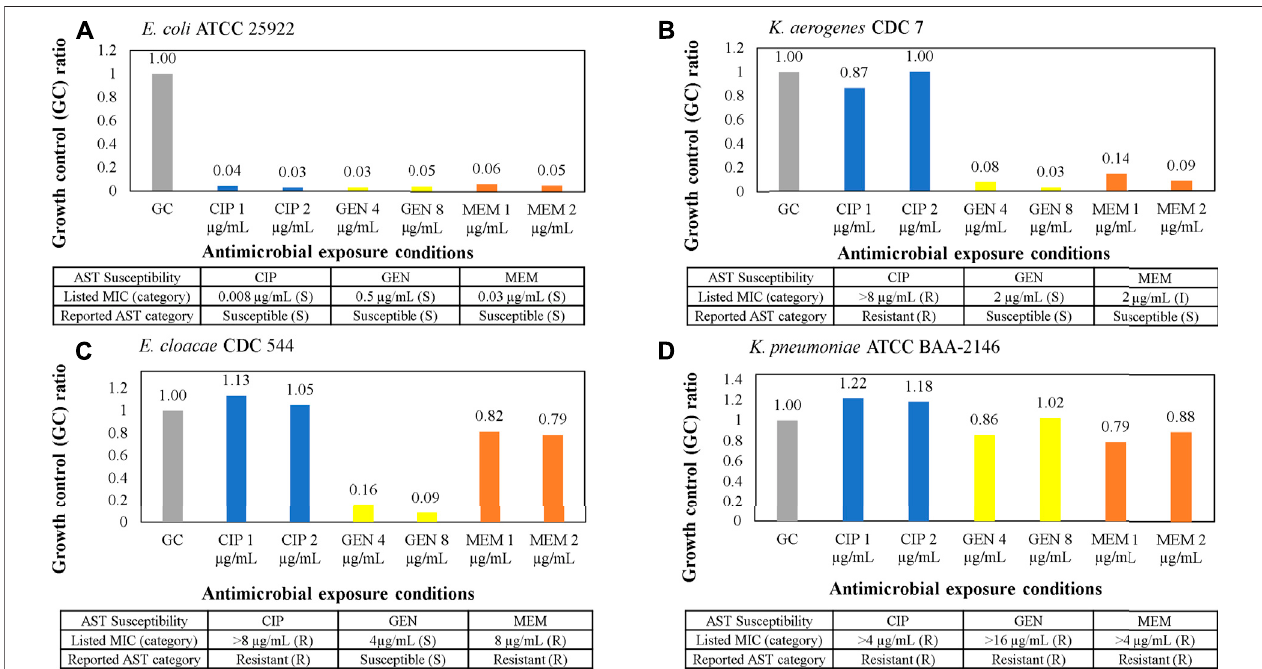
FIGURE6|(A – D) ASTassayfromclinicalisolatesusingtheASTstripwellin Figure4C .Microbiologicalresponsefromeachconditionforcipro fl oxacin,gentamicin, and meropenem AST stripwells with antibiotic concentrations on or near breakpoints. The microbiological response is plotted as growth control (GC) ratios, or electrochemical signal levels in nano amperes normalized to that of the